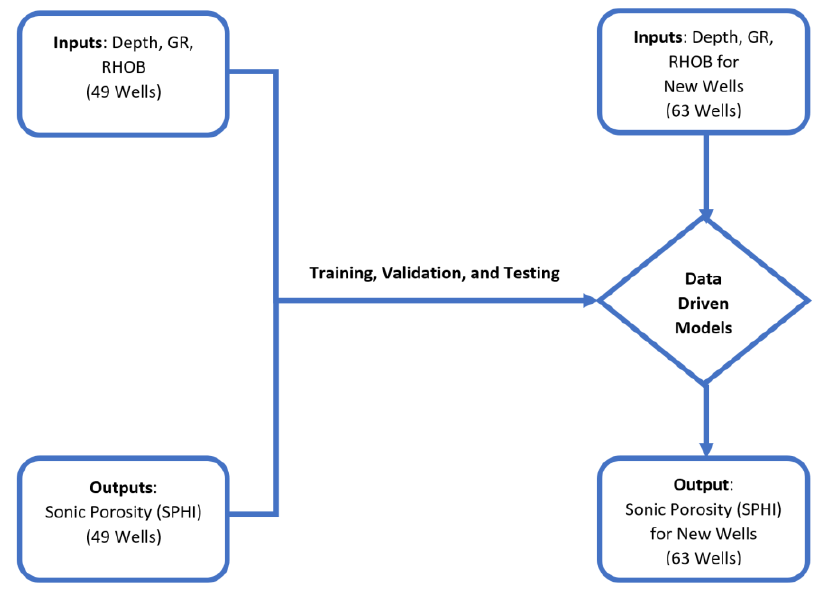
Figure 9. Flowchart process to obtain model to predict sonic porosity for new wells.